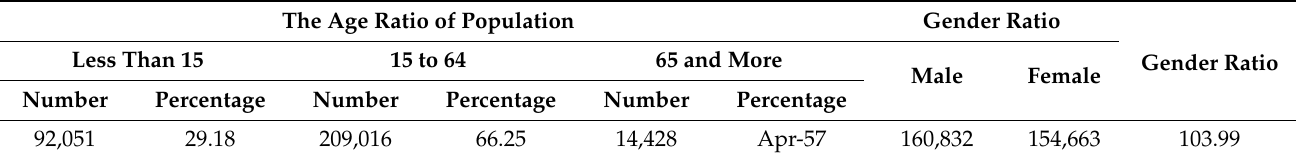
Table 4. Age and gender proportions of the population of Sanandaj city